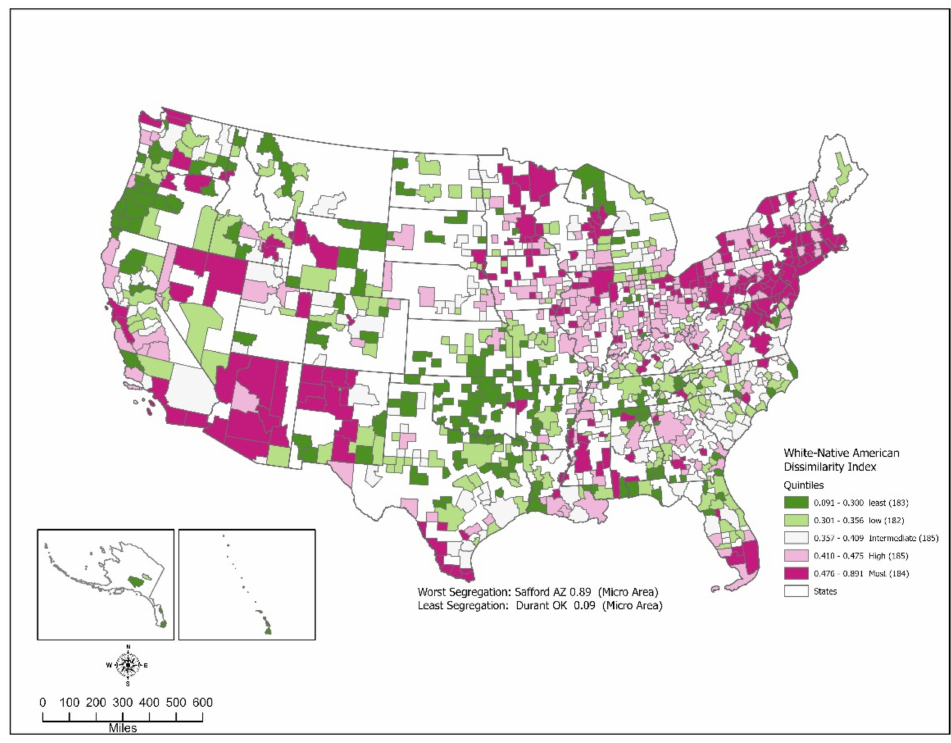
Figure 15. Native American-White Dissimilarity Indices, Metro/Micro Areas, 2020. Asian-White segregation was in the intermediate range with a median index of 0.399 and a mean index of 0.402. The lowest index was 0.1391, but the highest index was 0.729; thus, Asian-White segregation displayed a range of 0.593. Twenty-five percent of the areas had an index of 0.341 or less, while twenty-five percent had an index of 0.467 or greater. In many ways, the metro areas were more segregated than the micro areas; the median was 0.427 versus 0.385, respectively. The Micro areas displayed a broader range of indices than the metro areas (Tables 5 and 6). Table 5. Ten Highest Metro/Micro Areas for Black-White, Hispanic-White, Native American-White, and Asian-White Dissimilarity Indices